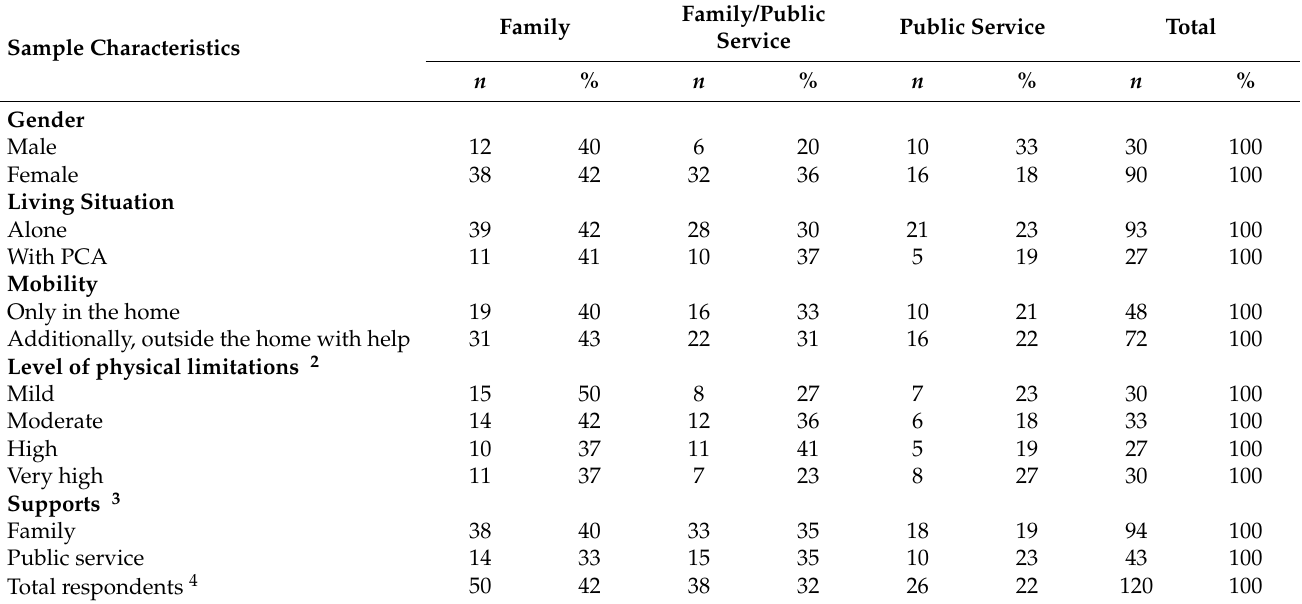
Table 6. Caring for older people: family or public responsibility 1 , by gender, living situation, mobility and supports received ( n ;